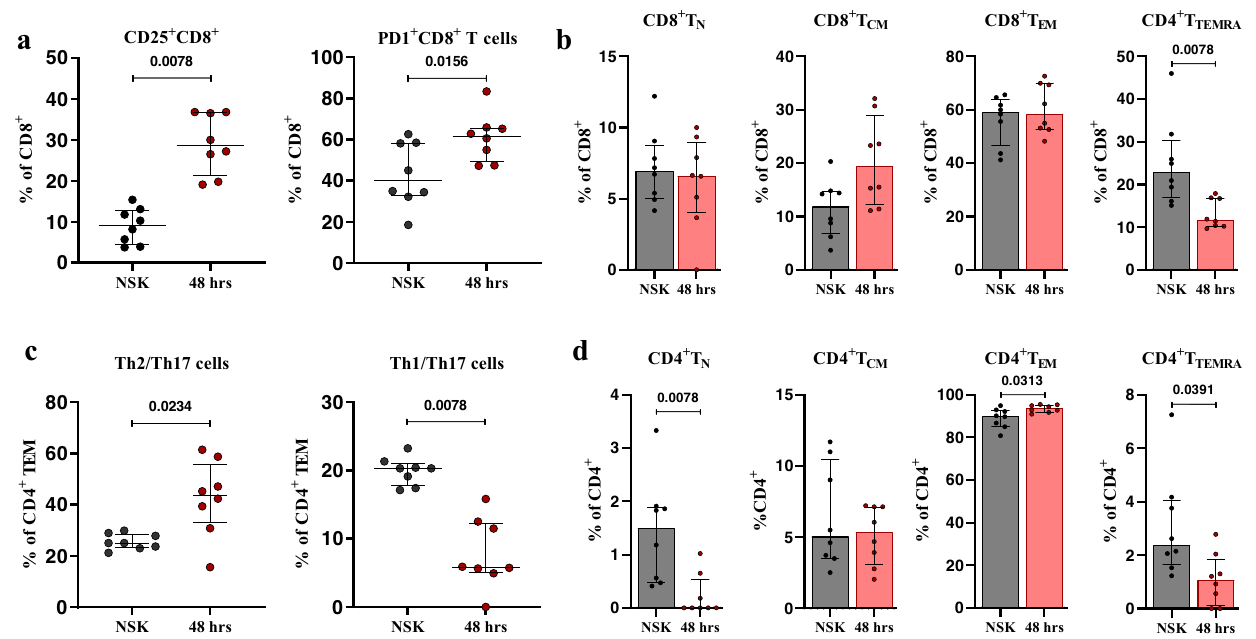
Fig. 6 | Changes in the T cell compartment are observable at 48h after mos- quito exposure. CD8 T cells exhibit a high activation phenotype, while CD4 T effector memory cells shift from a T h 1/T h 17 phenotype to a T h 2/T h 17 pheno- type. a Increased frequency of CD25 + and PD1 + CD8 T cells at 48h post mosquito exposure. b Frequencies of CD8 T cells naïve (CCR7 + CD45RA + ), central memory (CCR7 + CD45RA - ), effector memory (CCR7 - CD45RA - ), and TEMRA (CCR7 - CD54RA + ).